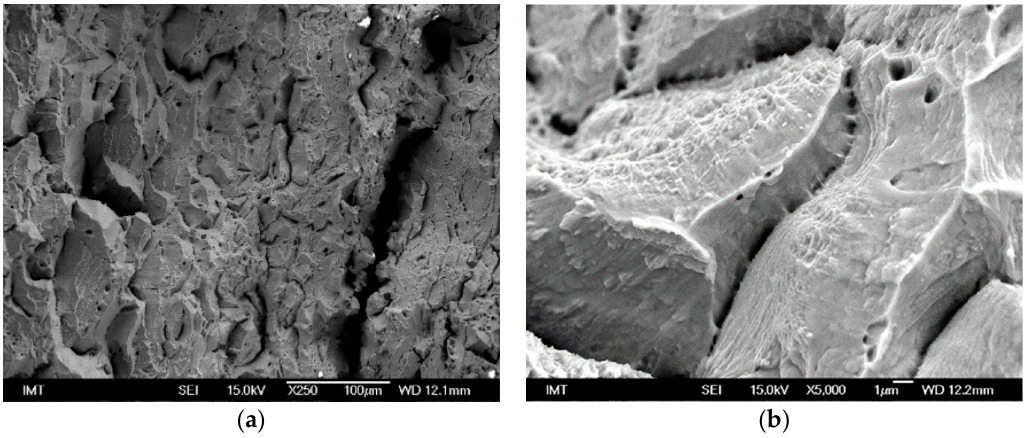
at 1050 °C with the deformation level of 23.5% and aged at 750 °C for 5 h ( b ).